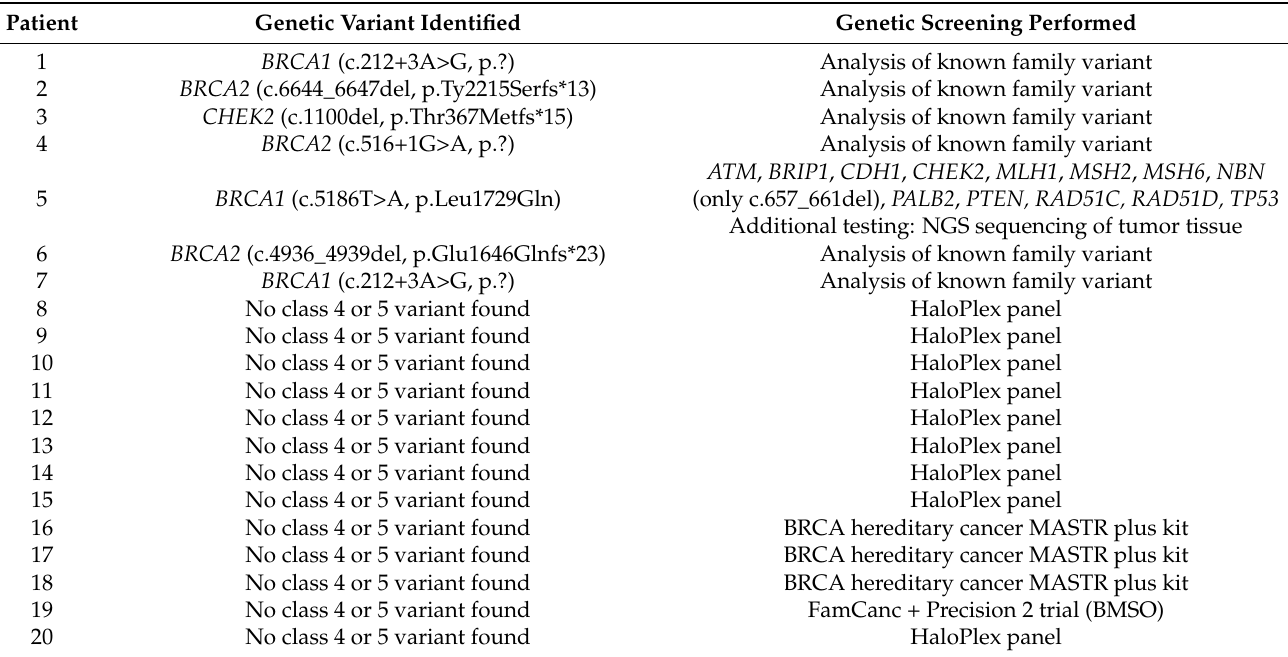
Table 3. Genetic testing performed in each